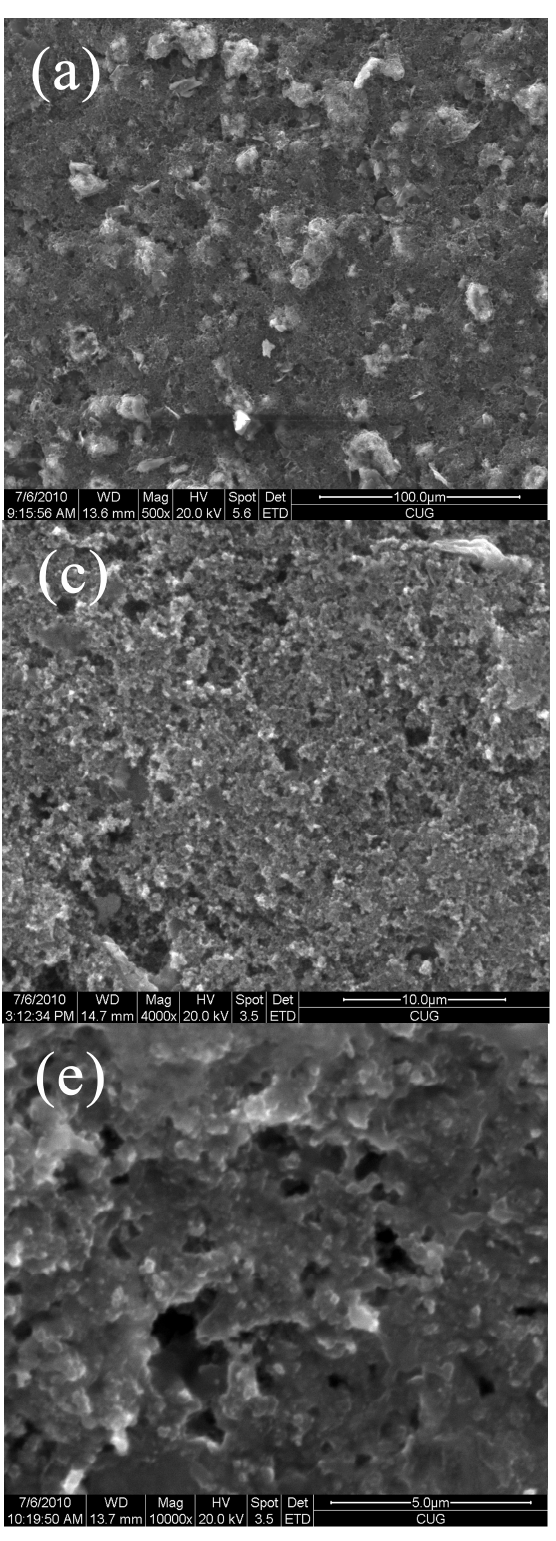
Figure 8. ESEM images of AB/S-4 electrodes during the initial discharge and charge process. ( a ) point D280 with 2.80 V; ( b ) point D215 with 2.15 V; ( c ) point D205 with 2.05 V; ( d ) point D195 with 1.95 V; ( e ) point D150 with 1.50 V; ( f ) point D280 with 2.80 V; ( g ) point C240 with 2.40 V; ( h ) point C300 with 3.00